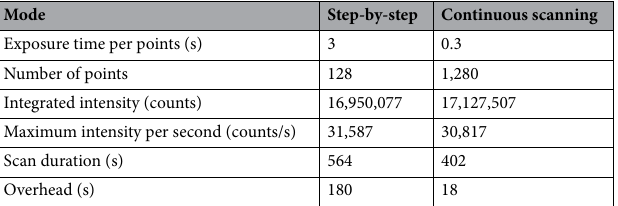
Table 1. Comparison between the two modes. Characteristics of the step-by-step and continuous scanning